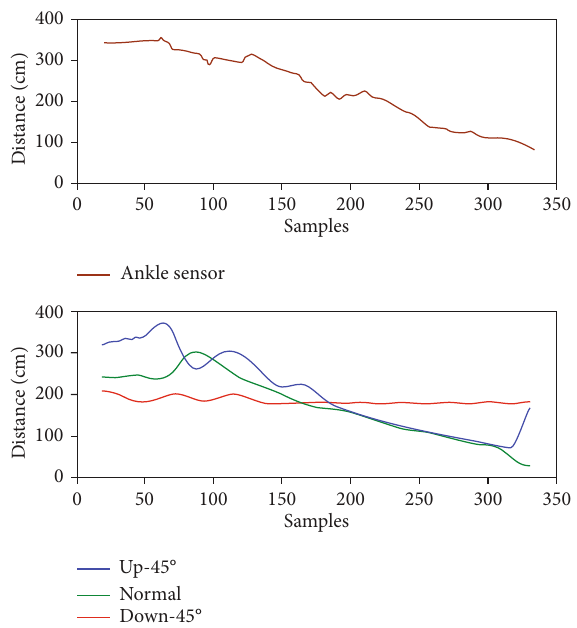
Figure 9: Actual sensor measurements after passing through a moving average fi lter (inclined obstacle up